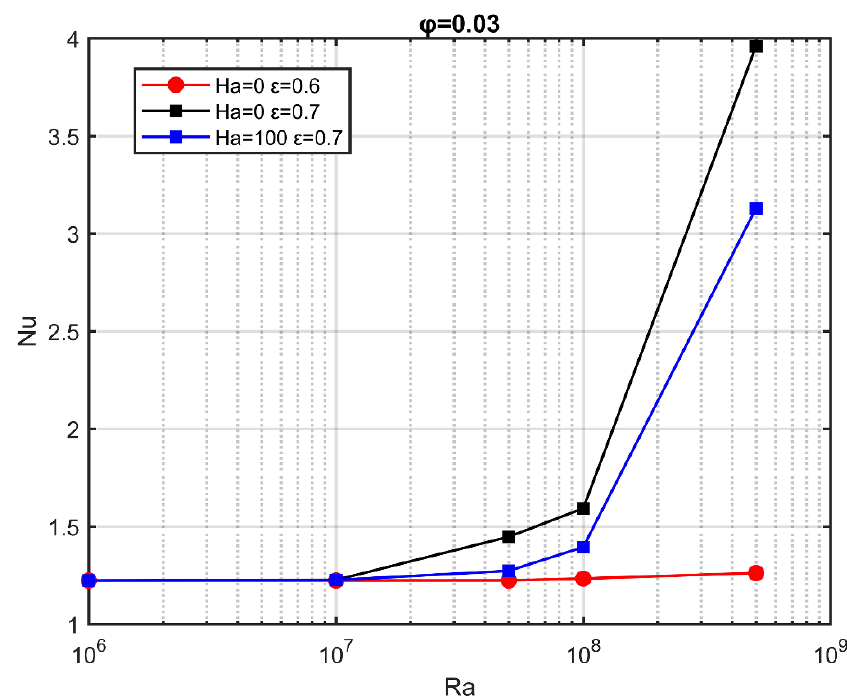
Figure 9. Average Nusselt number as a function of the Rayleigh number, for characteristic Hartmann numbers; ϕ = 0.03.